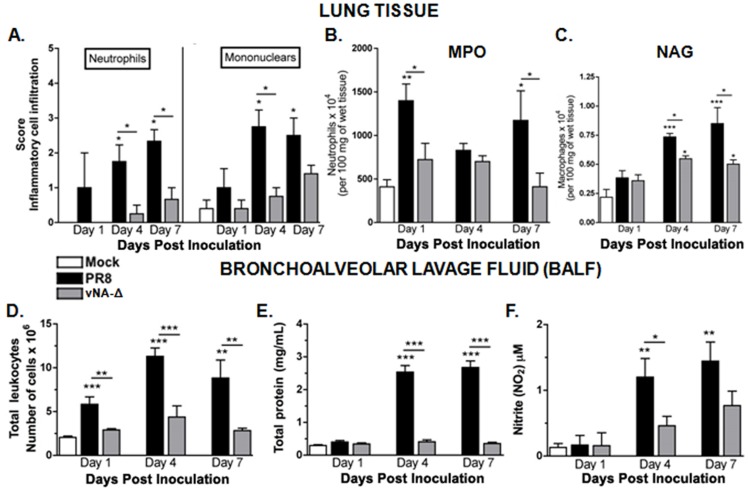
Leukocyte recruitment to the lungs and BAL following vNA-Δ infection.C57BL/6 mice were inoculated with PBS (mock) or infected intranasally with influenza 105 PFU of PR8 virus or vNA-Δ (n = 5). Mice were euthanized and lungs removed 1, 4 and 7 dpi. The recruitment of neutrophils and macrophages/mononuclear (A) cells to the lungs was assessed in lung H&E stained slides. Frozen lungs sections were assessed for Myeloperoxidase (B) and N-acetylglucosaminidase (C) contents, indirect measurements for neutrophils and macrophages, respectively. Mice were euthanized (n  =  6–8 in each group) 1, 4 and 7 dpi and bronchoalveolar lavage was performed. Absolute numbers of airways leukocytes after infection with 105 PFU (D). Total proteins (E) and nitrite (NO2−; F) were also determined in BALF. Data are presented as mean ± SEM. *, ** and *** for p<0.05, p<0.01 and p<0.001, respectively, when compared to mock or indicated groups (one-way ANOVA, Newman-Keuls).